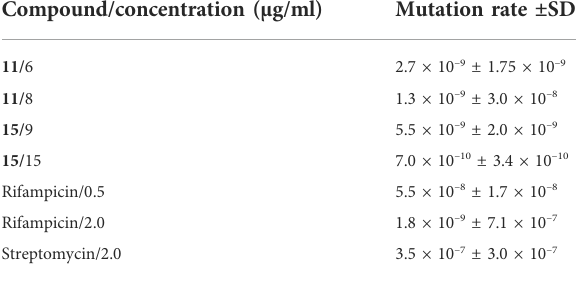
TABLE 2 The mutation rate of tubercle bacilli calculated for the investigated compounds and anti-TB drugs.